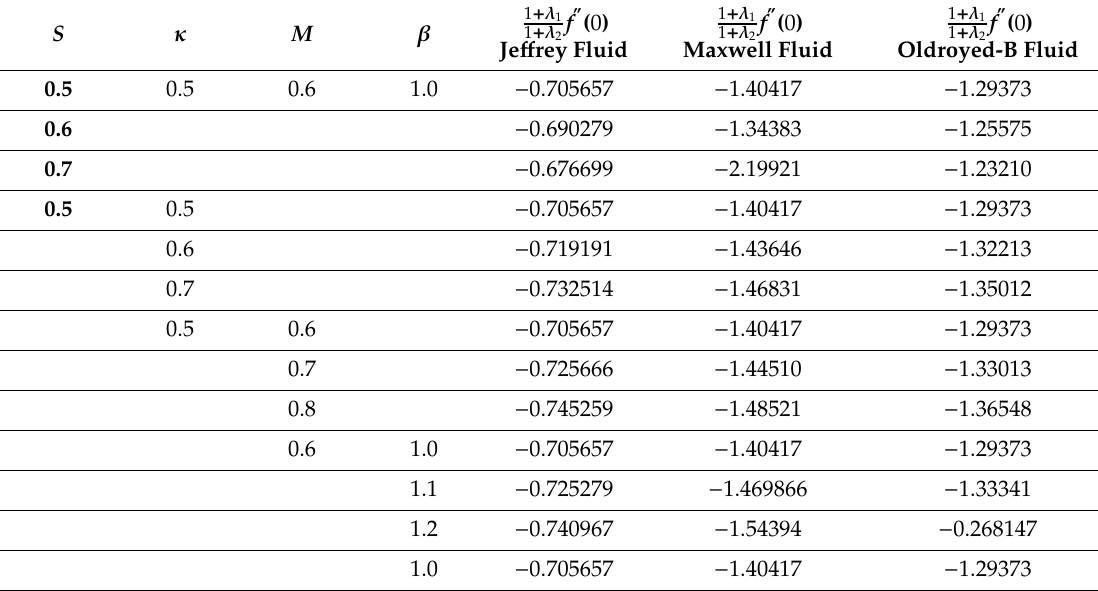
Table 4. Numerical values for the skin friction coe ffi cient for several physical parameters